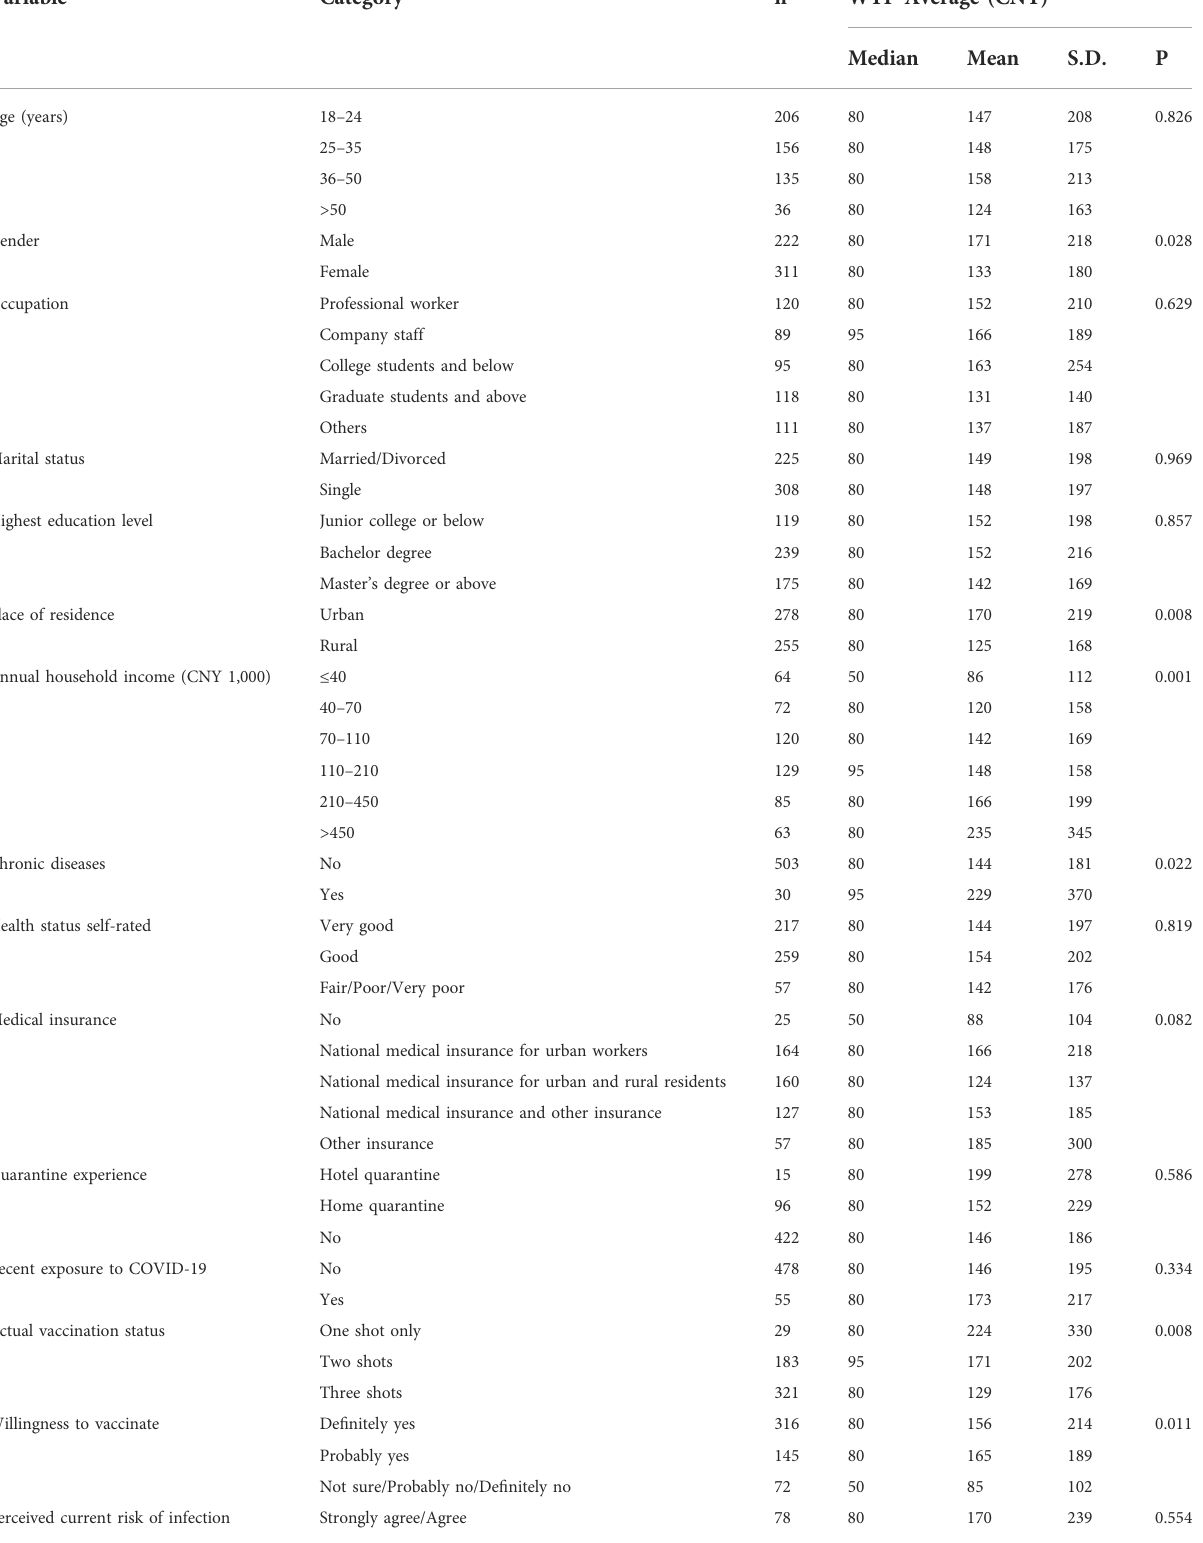
TABLE 2 Willingness to pay in different